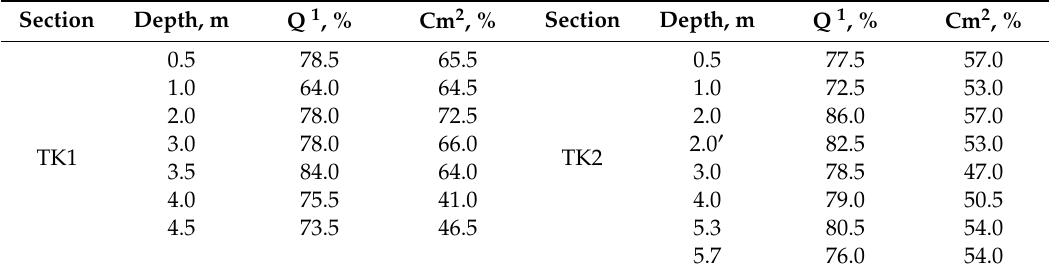
Table 3. Morphometric properties of the quartz sand-grains from studied